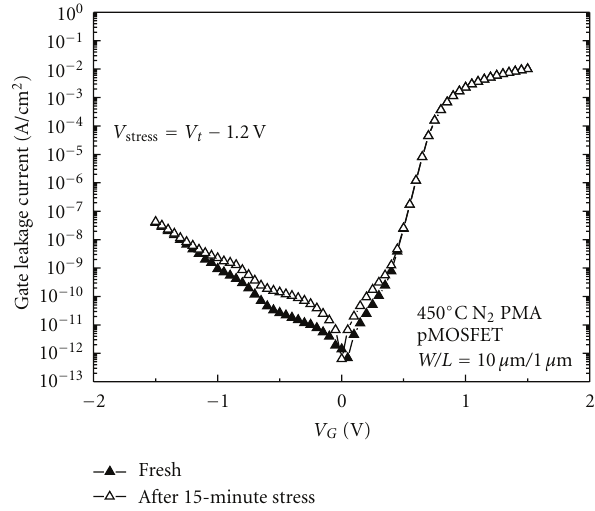
Figure 7: The I G - V G curves of 450 ◦ C, N 2 annealed sample before and after stress.